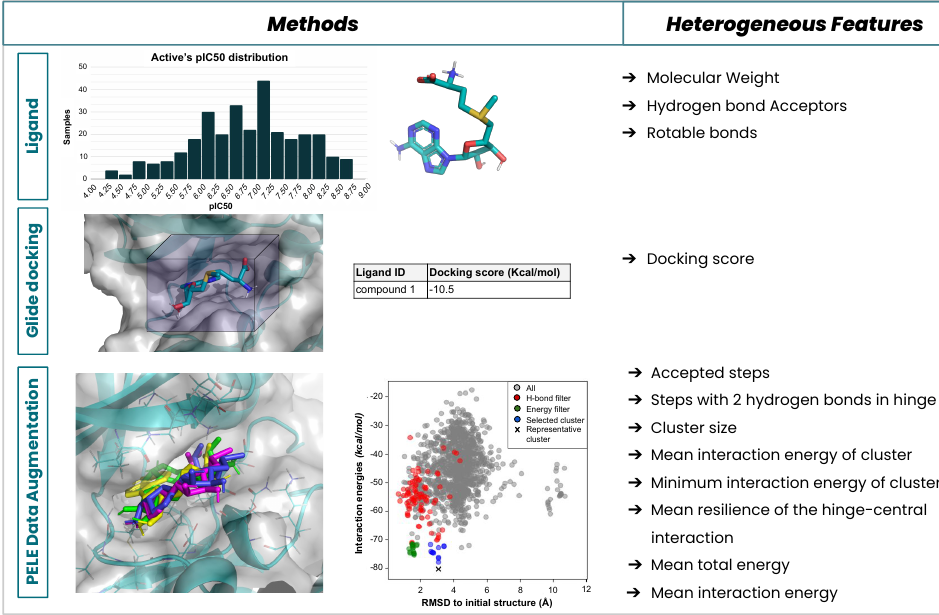
Figure 1. Heterogeneous data extraction and feature build-up in our recent prospective study for the Almirall company. Different levels of model description and molecular modelling provided several features for training a model with a set of experimentally validated